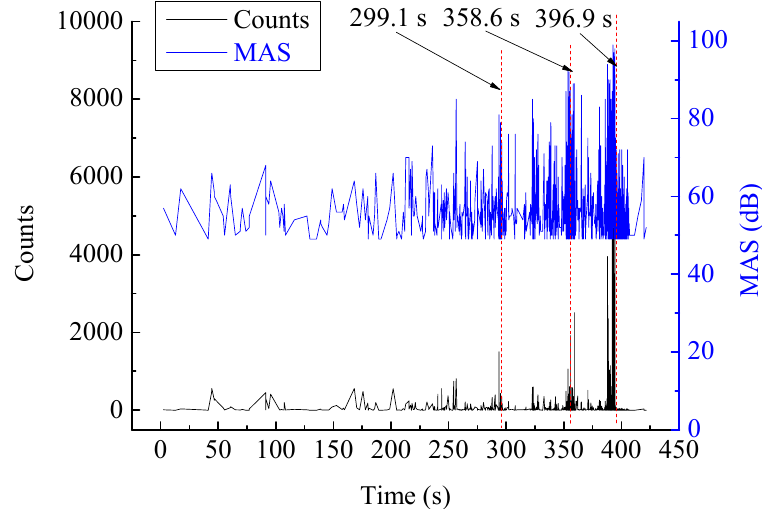
Figure 6. Curves of AE counts and MAS with respect to loading time.